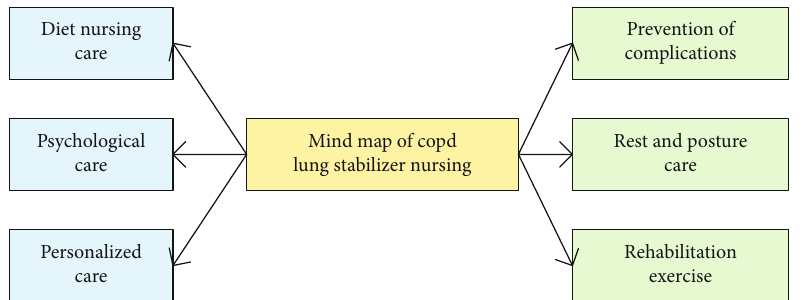
Figure 6: Mind map of nursing care of patients with COPD